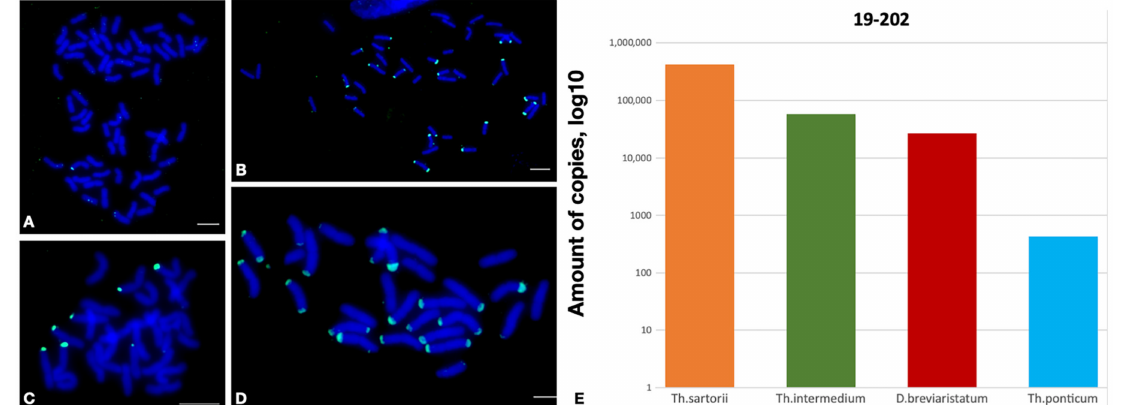
Figure 3. Localization of the 19-202 tandem repeat on the metaphase chromosomes of ( A ) Thinopyrum ponticum PI 636523; ( B ) Thinopyrum intermedium PI 401200; ( C ) Dasypyrum breviaristatum PI 516547; and ( D ) Thinopyrum sartorii PI 531745, using fluorescence in situ hybridization. Green signals indicate the chromosomal localization of 19-202 tandem repeat. The bar indicates 10 µ m. ( E ) Histogram of the copy number of tandem repeat 19-202 in Thinopyrum sartorii PI 531745, Thinopyrum intermedium PI 401200, Dasypyrum breviaristatum PI 516547, and Thinopyrum ponticum PI